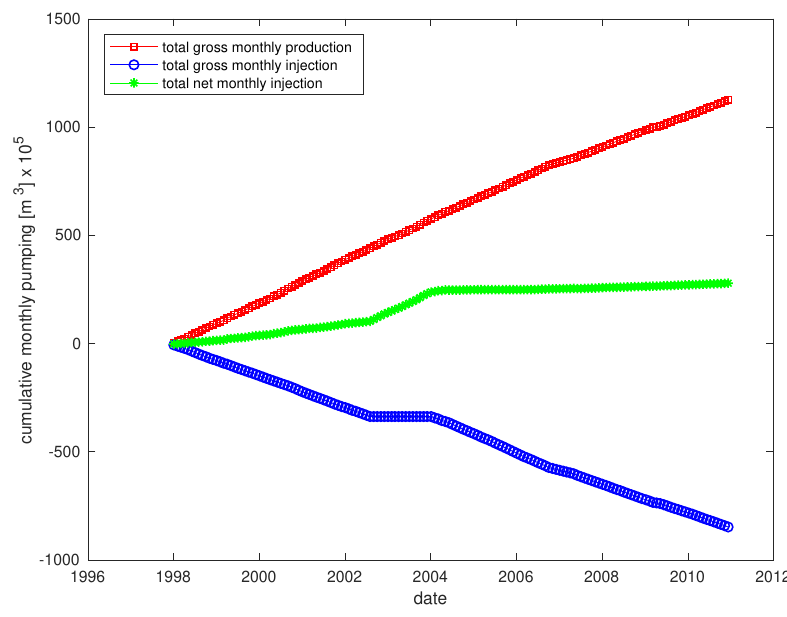
Figure A11. Time series of cumulative total monthly gross injection (blue), cumulative total monthly gross production (red), and cumulative total monthly net production (green) at San Emidio in m 3 . Data are from Ormat as reported to the State of